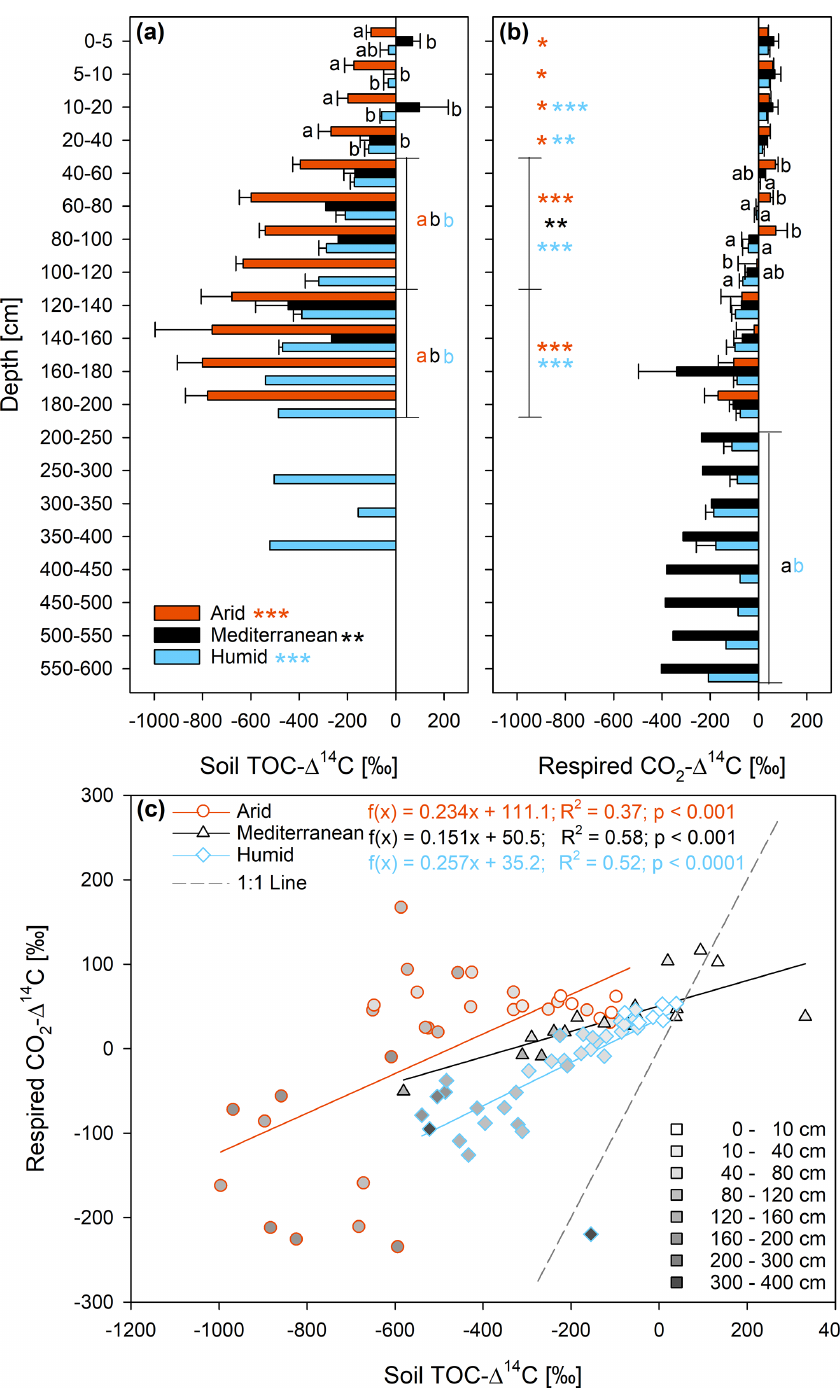
Figure 2. Radiocarbon ratio ( (cid:49) 14 C; mean ± standard error) of (a) soil total organic carbon (TOC) and (b) respired CO 2 –C as well as (c) their relationship in soils at three sites (arid, mediterranean, humid) located along a precipitation gradient in the Coastal Cordillera of Chile (0– 200cm: n = 3, except for humid site with n = 4; > 200cm: n = 1, except for humid site 200–400cm with n = 2). Different letters in (a) and (b) indicate significant differences ( p ≤ 0 . 05) among the sites tested by Tukey’s post hoc test after two-way ANOVA. Asterisks indicate significant differences between the radiocarbon ratio of the total soil organic carbon (TOC) and that of the respired CO 2 –C for each site, tested across all soil depth increments (see legend) and also separately for the different sites and depth increments ( ∗ p ≤ 0 . 05, ∗∗ p ≤ 0 . 01, ∗∗∗ p ≤ 0 . 001). The colors of the asterisks indicate the site the asterisks refer to. Lines in (a) and (b) indicate which soil depth increments were combined (separately per site) for statistical